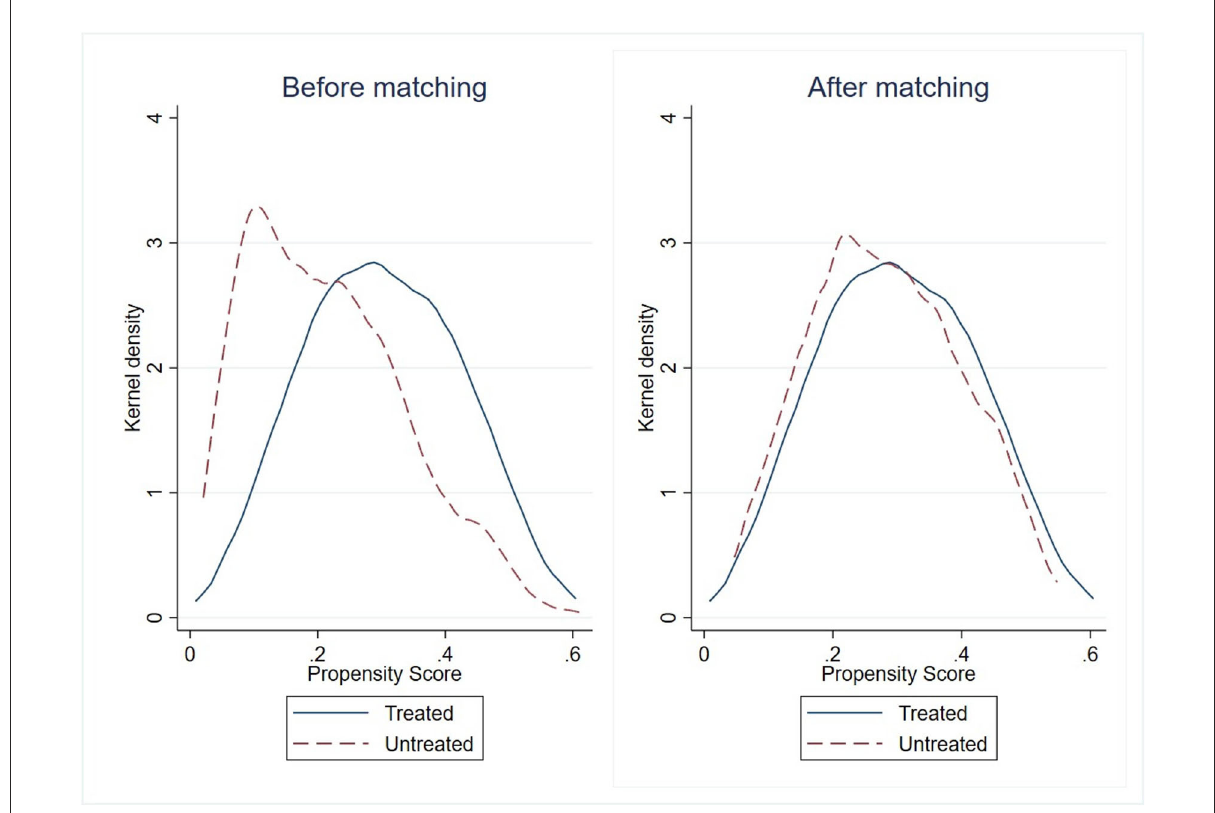
FIGURE5 Kernel density